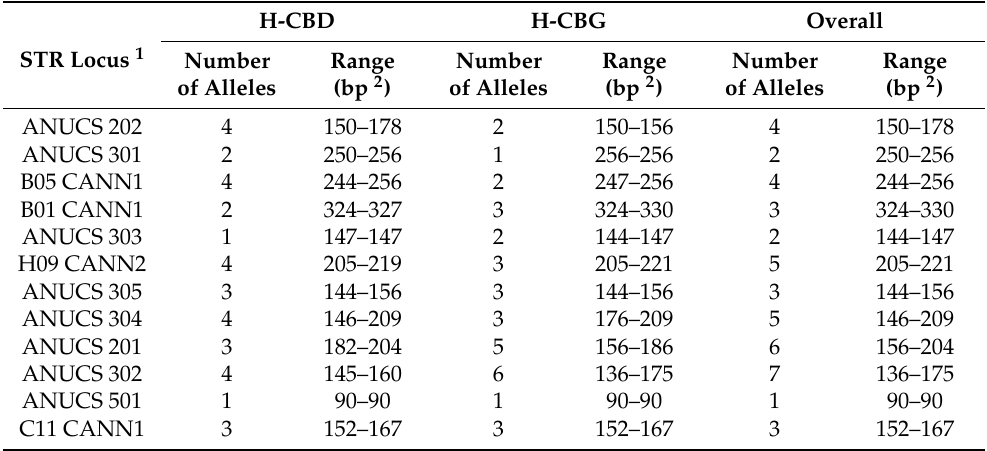
1 Short tandem repeat, 2 bp = base pairs.